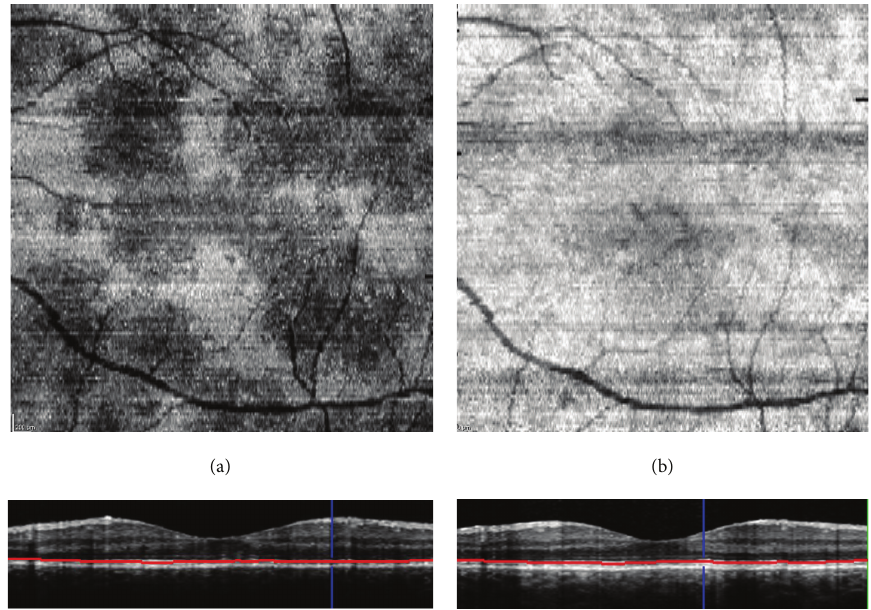
Figure 6: (a) “En-face” EDI SD-OCT, at the level of the ellipsoid zone in the acute phase, showing hyporeflective areas. (b) “En-face” EDI SD-OCT, at the level of the ellipsoid zone at 6-month follow-up, showing incomplete recovery of the ellipsoid